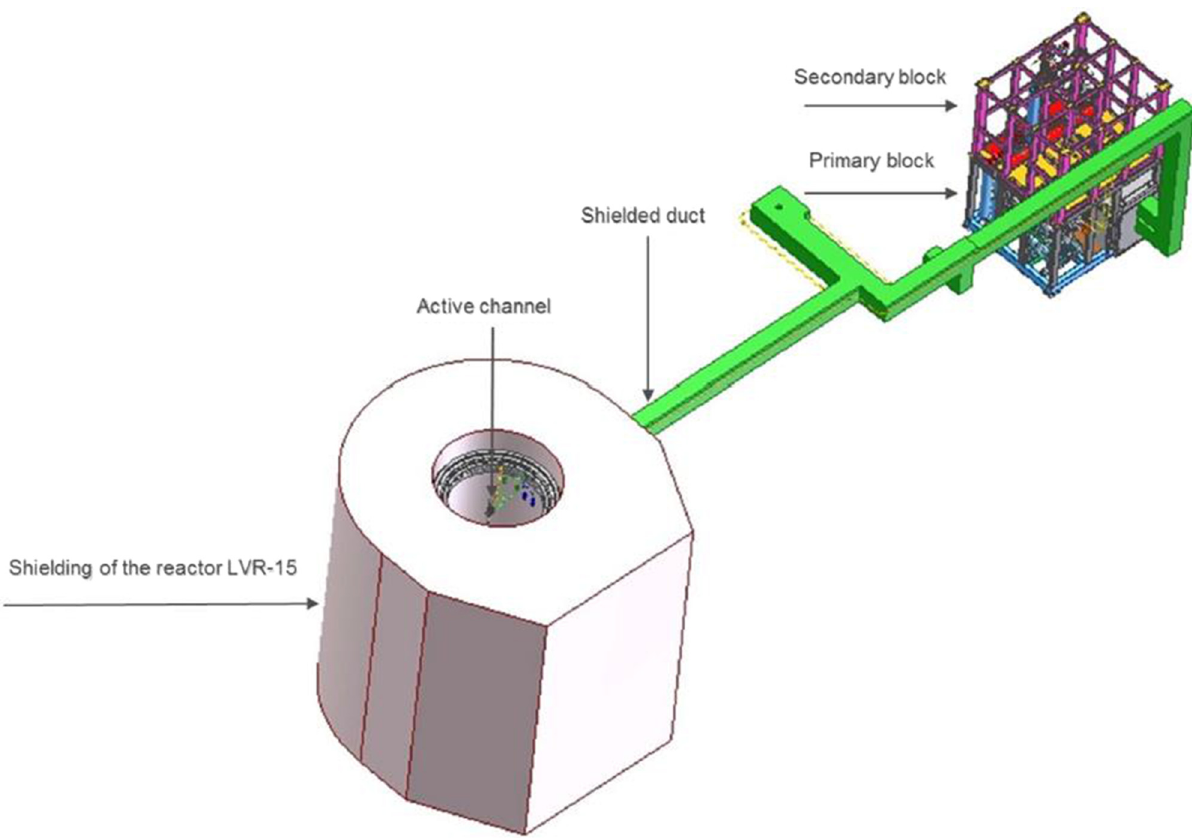
Fig. 4. SCWL-FQT loop and LVR-15 reactor